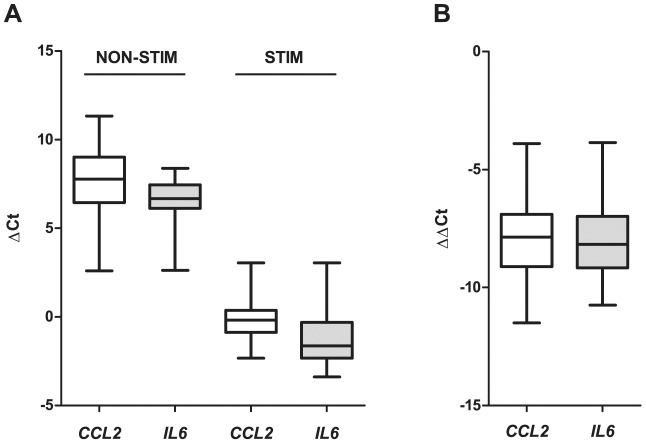
Whisker plots of CCL2 and IL6 transcript levels in whole blood cultures in the presence an absence of M. leprae sonicate.Whole blood from 62 Vietnamese subjects was stimulated with 10 µg/ml M. leprae sonicate and transcript levels of CCL2 and IL-6 were determined by real time PCR. (A) Transcript levels were normalized with the HPRT house keeping gene and expressed as ΔCt in the absence (NON-STIM) and presence (STIM) of M. leprae sonicate. The median of the distribution is indicated by a solid line within the box. The resulting subdivision of the box indicates the distribution of the flanking 25% percentile in each direction while the error bars give the distribution of the upper and lower 25% of the ΔCt values. (B) The increase of CCL2 and IL6 transcripts resulting from stimulation with M. leprae sonicate expressed as ΔΔCt. Plots as described in A.